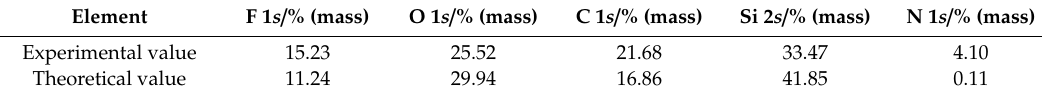
Figure 6. XPS survey spectrum ( a ) and high-resolution C 1 s ( b ), N 1 s ( c ), and Si 2 p ( d ) spectra. Table 2. Atomic composition of the PFAS-SiO 2 -3 film on the fabric surface.